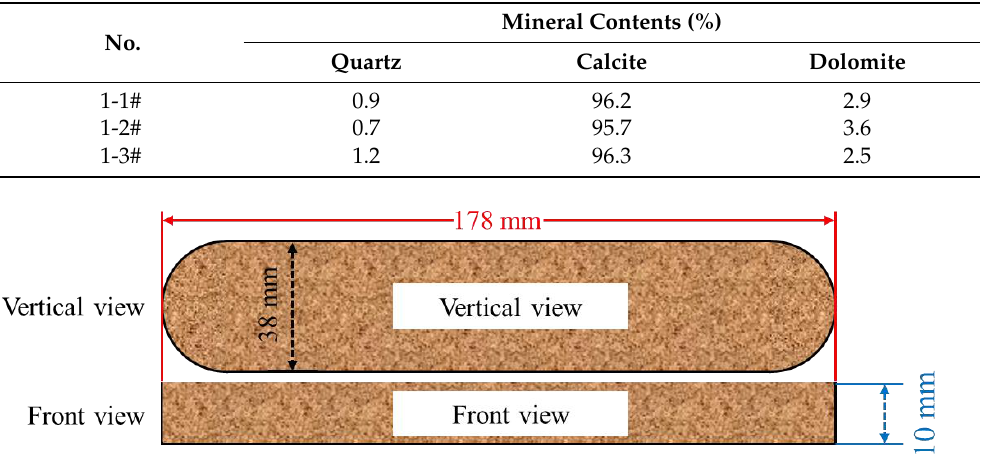
Table 1. XRD mineral analysis results.